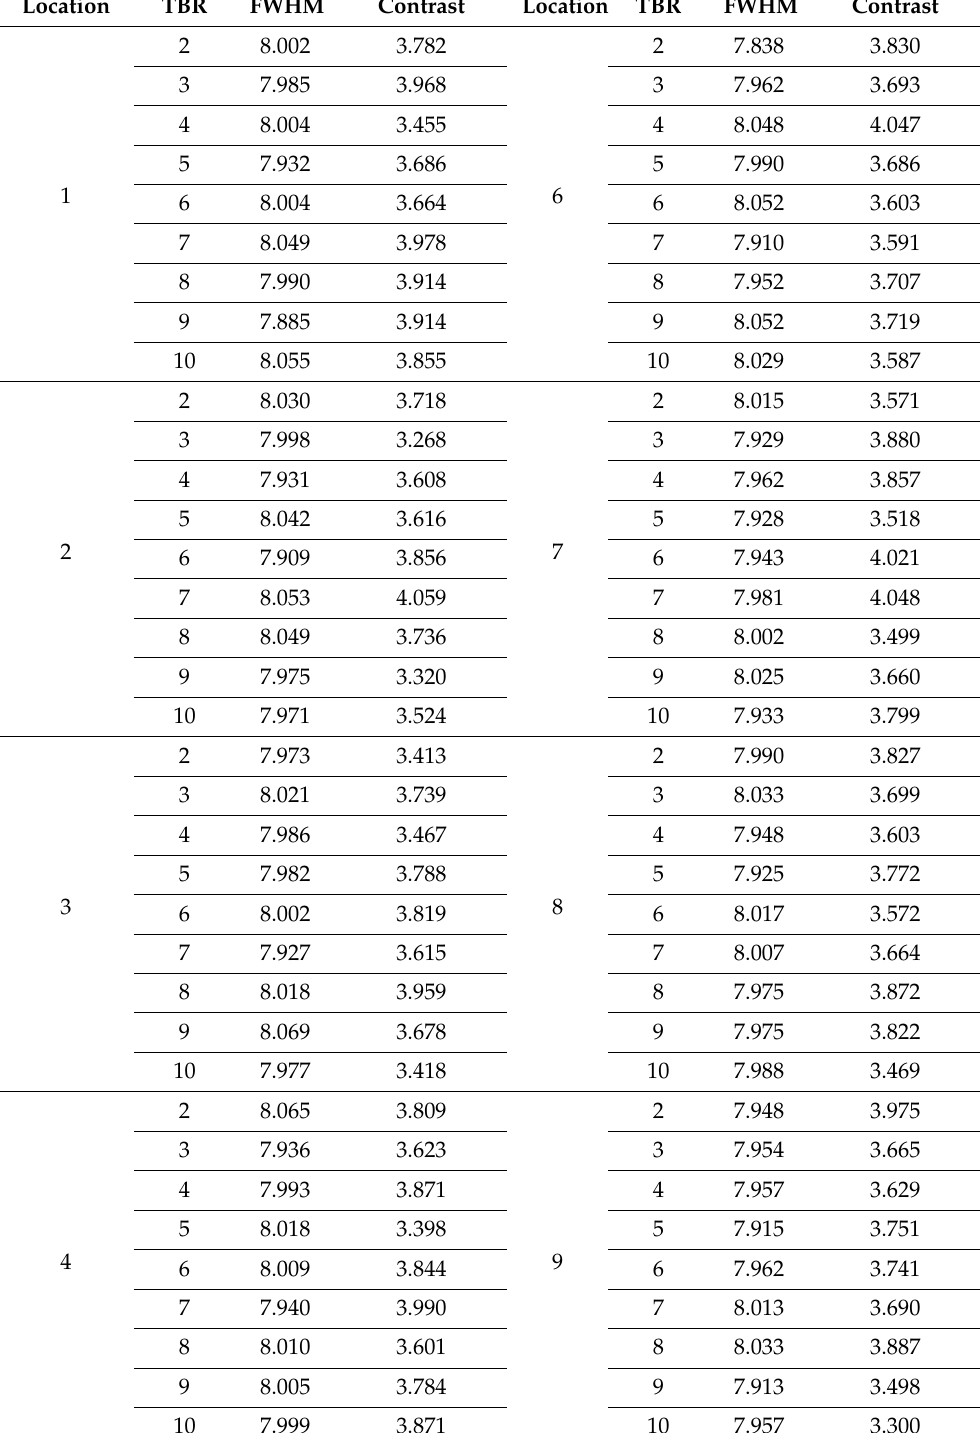
Table 1. FWHM and contrast parameter for all 22 studied locations and 9 TBR